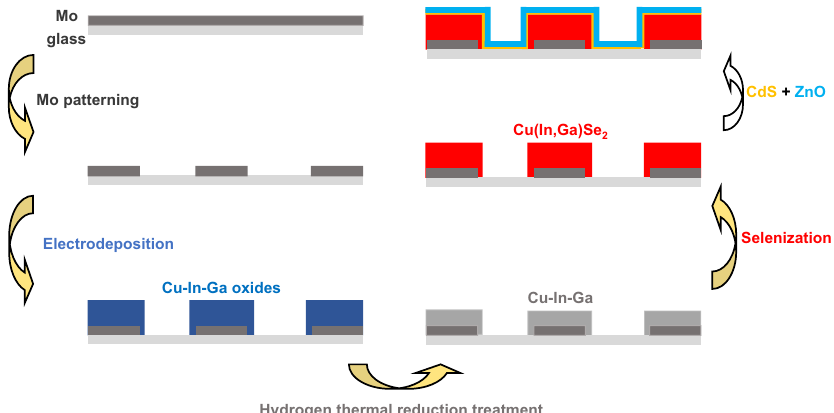
Fig. 1. Processing steps for the fabrication of semi-transparent CIGS solar cells based on the Glass/patterned